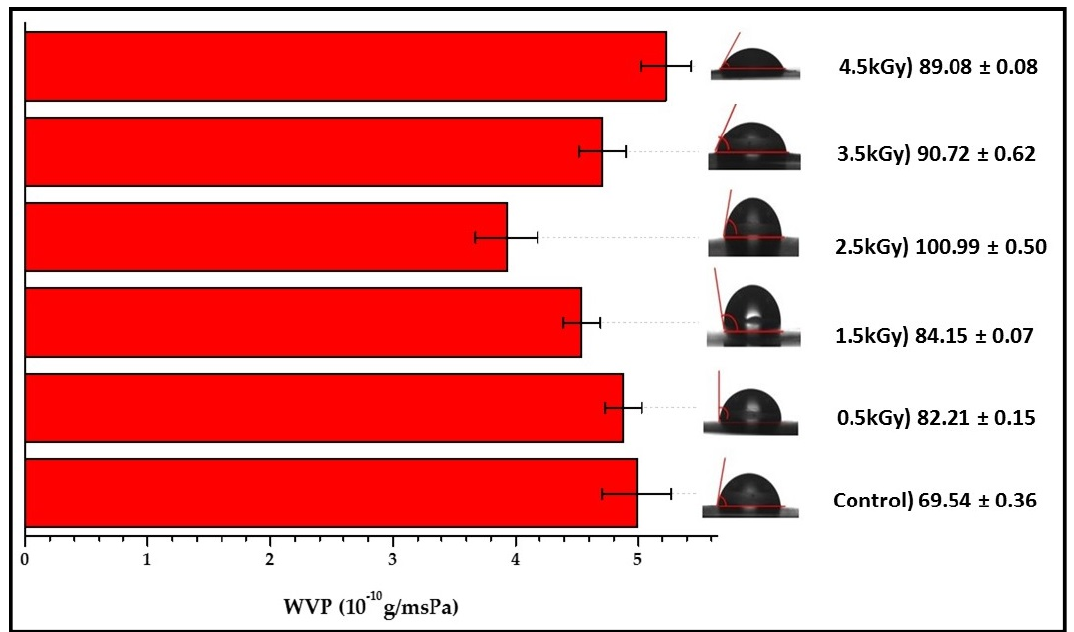
Figure 5. Water vapour permeability and contact angle of seaweed-neem films with different doses of